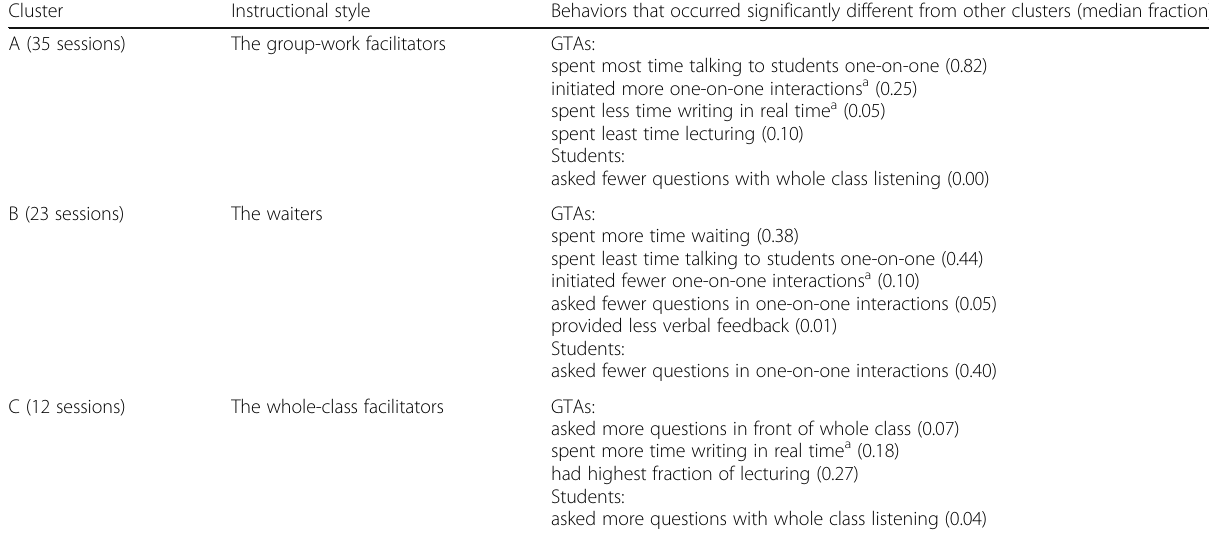
Table 5 Characteristics of physics GTAs ’ instructional practices in each cluster